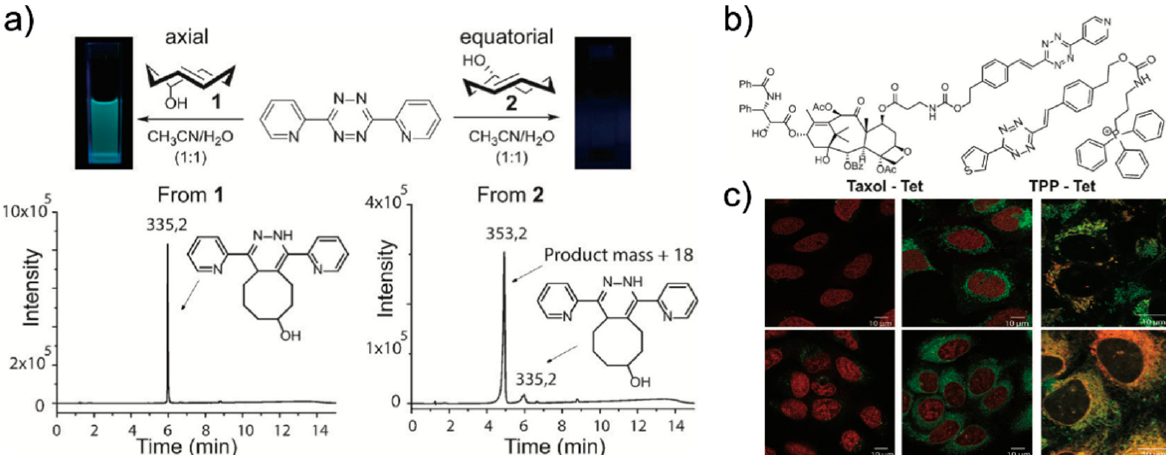
Figure 8. Formation of a new fluorophore after an iEDDA reaction. ( a ) Reaction between 3,6-di(2 (cid:48) -pyridyl)-5-tetrazine (DiPyTet) and TCO gave different products. In this study, the reaction of the axial TCO isomer (TCOa) with DiPyTet resulted in new fluorophore formation. ( b ) Chemical structure of tetrazine modified with Taxol ® and TPP (Taxol ® –Tet and TPP–Tet, respectively) in this study. ( c ) Confocal laser microscope images of U2OS cells treated with Taxol ® –Tet (upper row) or TPP–Tet (lower row), followed by DMSO (left column) or TCOa (middle column) treatment. The merged images obtained from co-staining experiments with commercial mitotracker or tublin tracker (right column) confirmed the specificity of the probes. Reproduced from